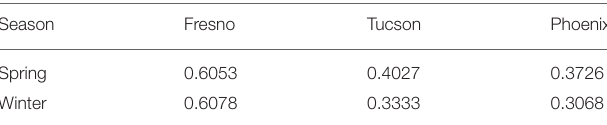
TABLE 3 | Nested Sørensen dissimilarities between regional species pools and urban assemblages for each city and season.